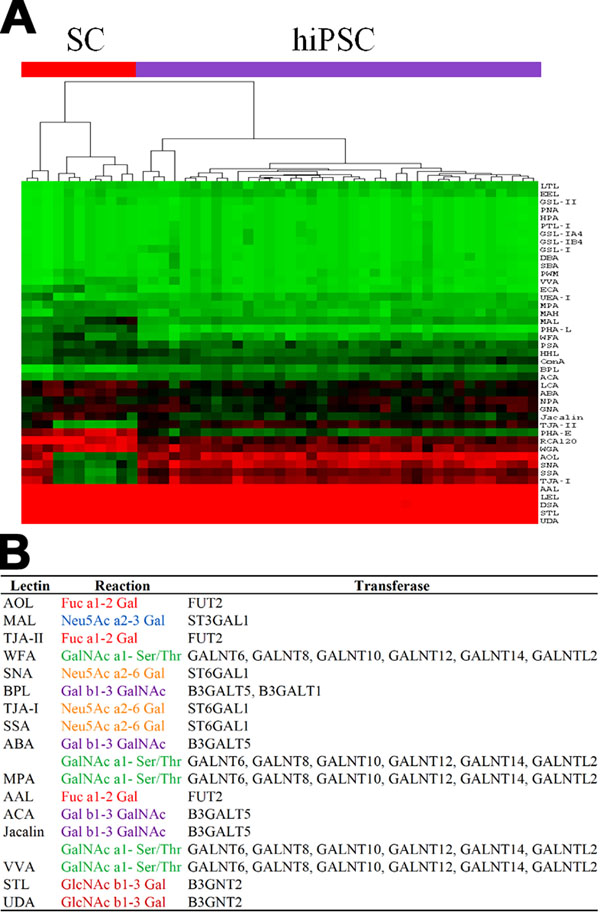
Glycan signature (A) Heat map and hierarchical clustering of lectins. The hiPSCs and parental SCs are depicted by colored bars (red, SCs; purple, hiPSCs). (B) Correspondence between lectin gene expression patterns and glycan signatures. The lectin-glycosyltransferase relationships are described, together with their reactions. The lectins were selected under the condition that the corresponding glycosyltransferases were found in the expression signature.